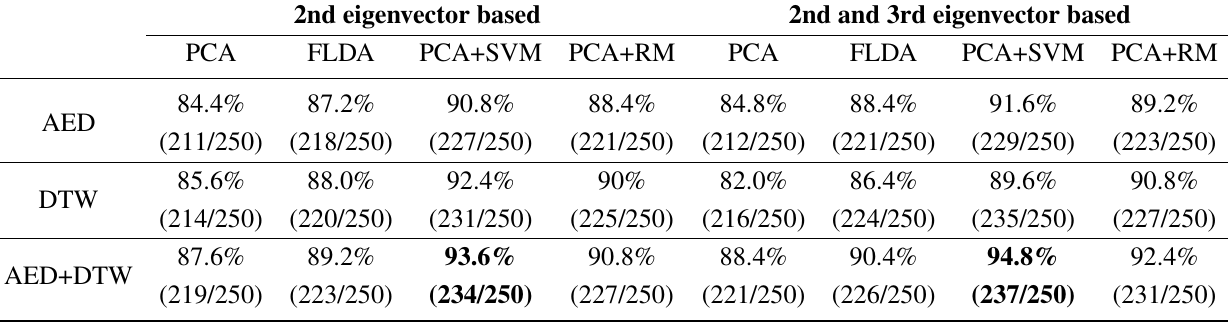
Table 8. Recognition rate results of fusion between proposed 3D face recognition and 2D face recognition (Rank-1